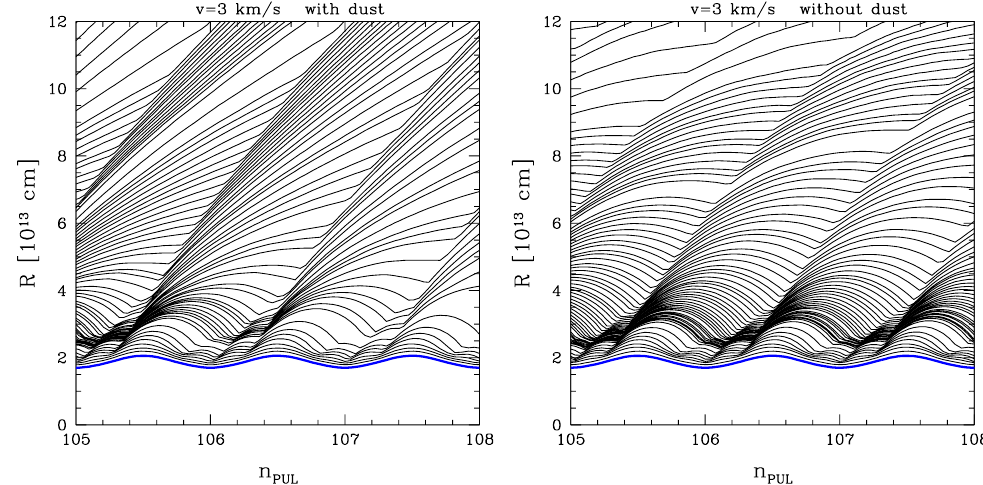
Figure 4. Temporal evolution of the radius coordinate of selected Lagrangian zones (with and without dust). Each curve follows the radial evolution of a mass shell. The innermost curve corresponds to the